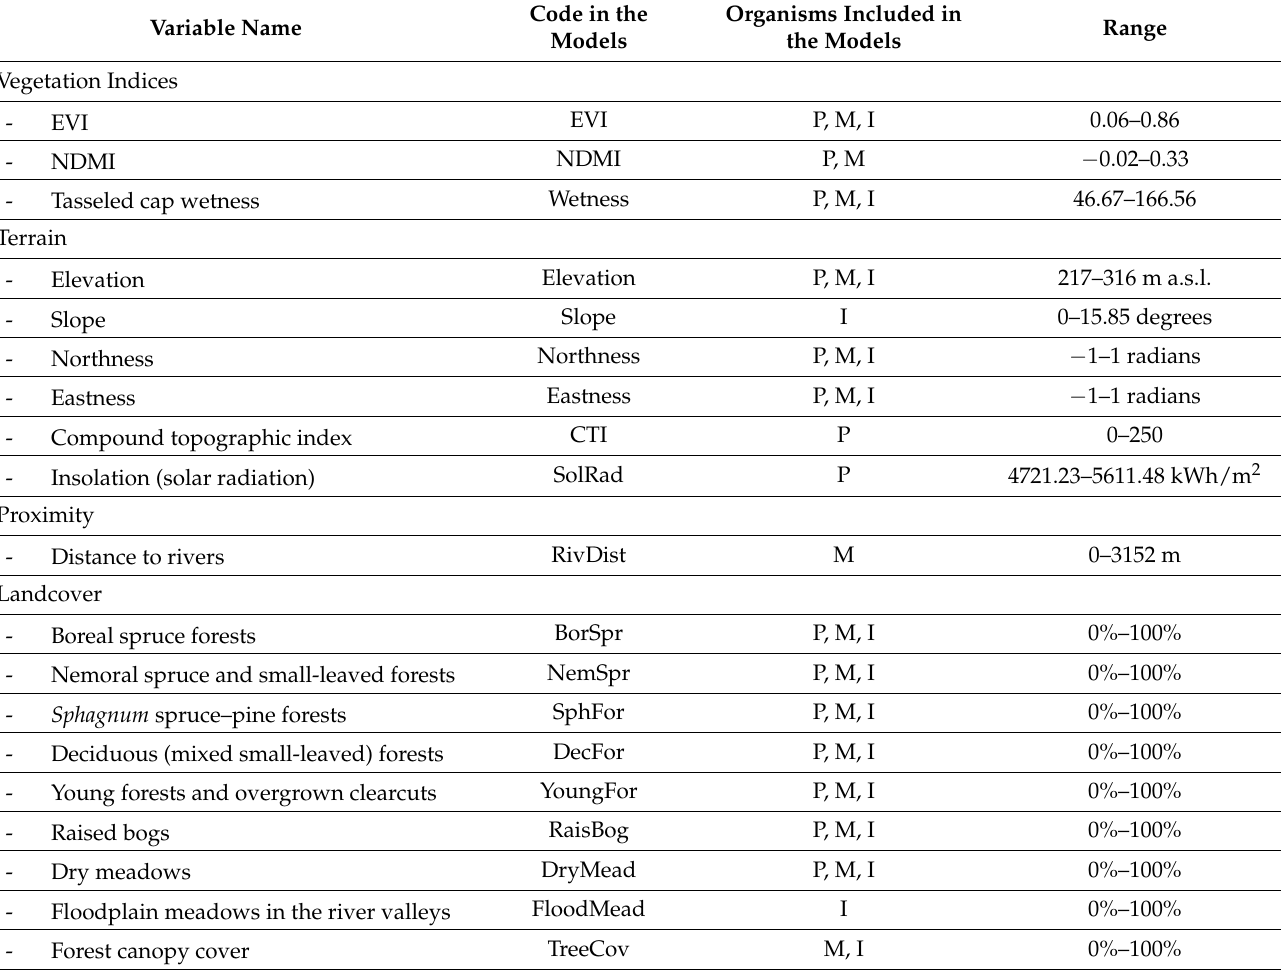
Table 1. Environmental variables used as predictors for the 14 brown bear food-probability models in the Central Forest State Nature Reserve (West-European Russia) in 2008–2020. Organisms included in the models are plants (P), mammals (M), and insects